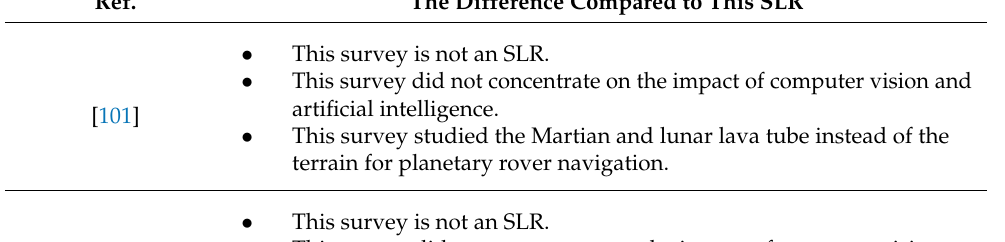
Table A1. The comparison between this SLR and similar surveys. Ref. The Difference Compared to This